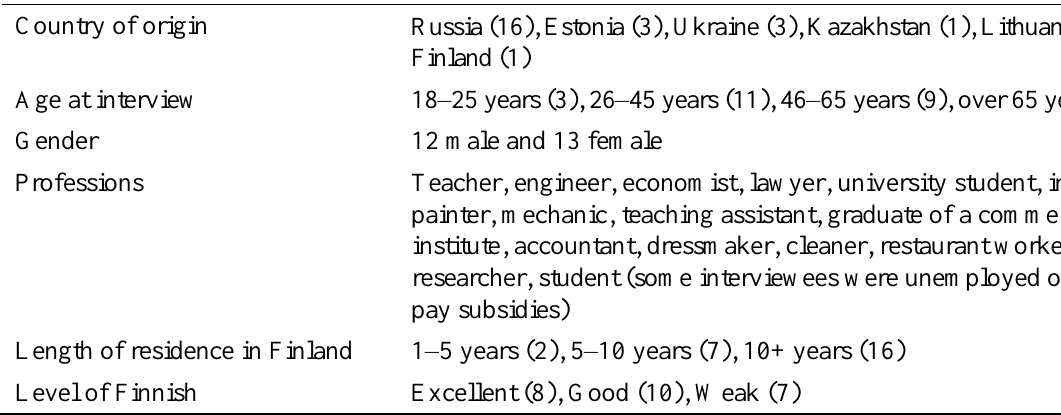
Table 1. Information on